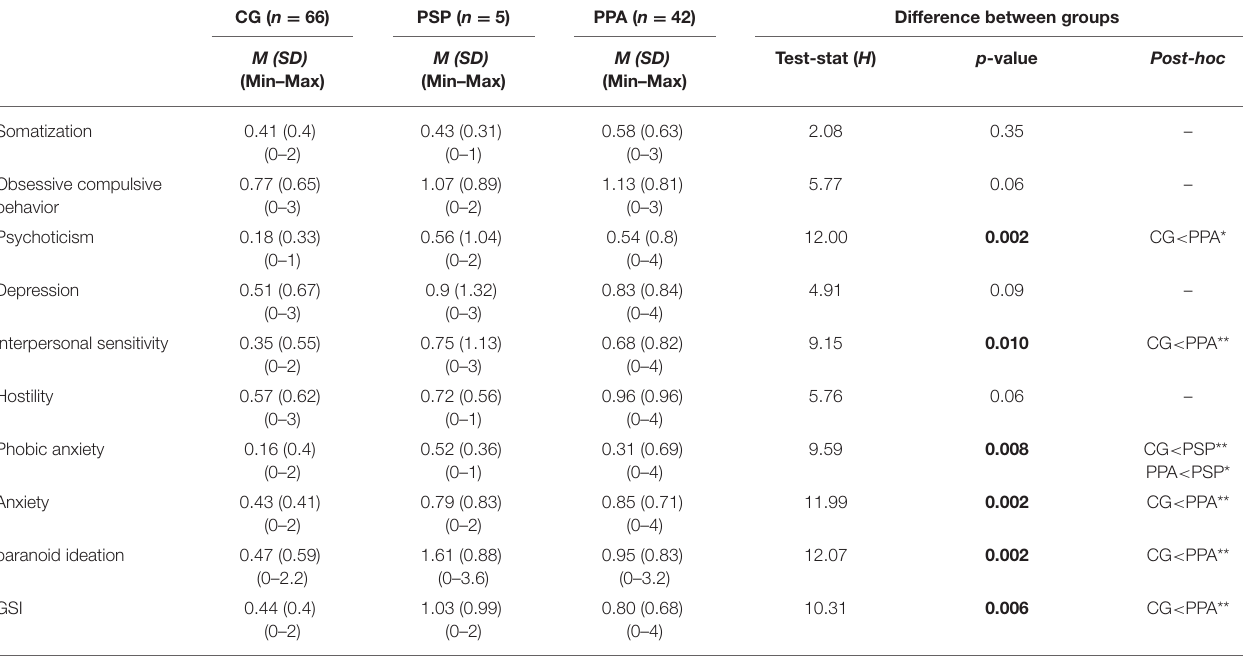
TABLE 4 | Self-reported psychiatric distress level in a sample of male adolescents according to psychosocial variable